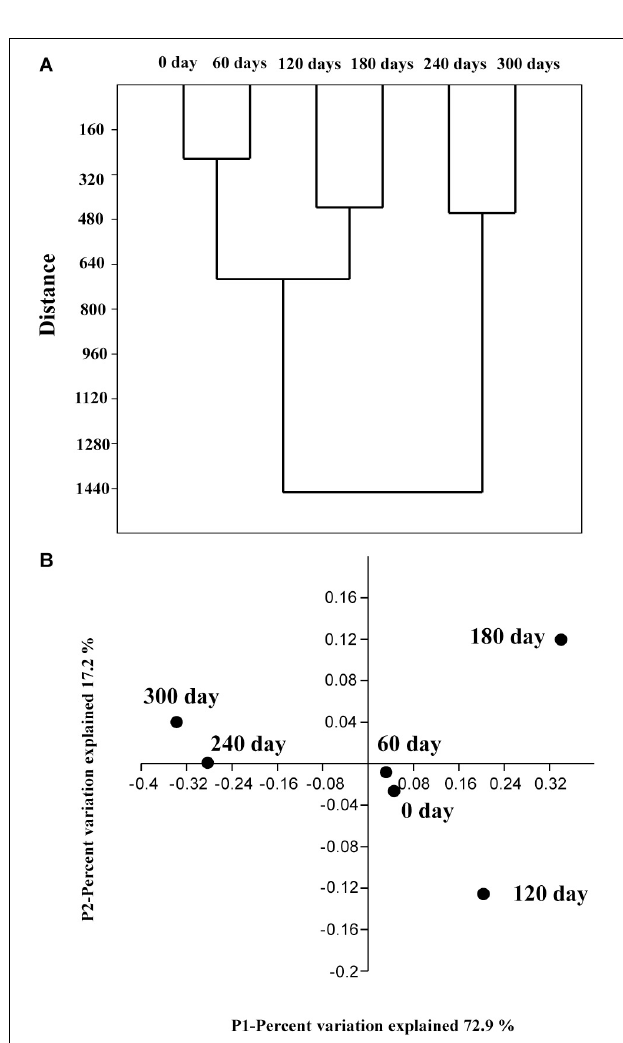
FIGURE 5 | Cluster analysis based on the Bray–Curtis distance (A) at the genus level with a 3% cutoff. The genera were divided into three groups. The four-dimensional principal coordinate plot obtained using the genus results of samples collected from 6 enriched times in (B).